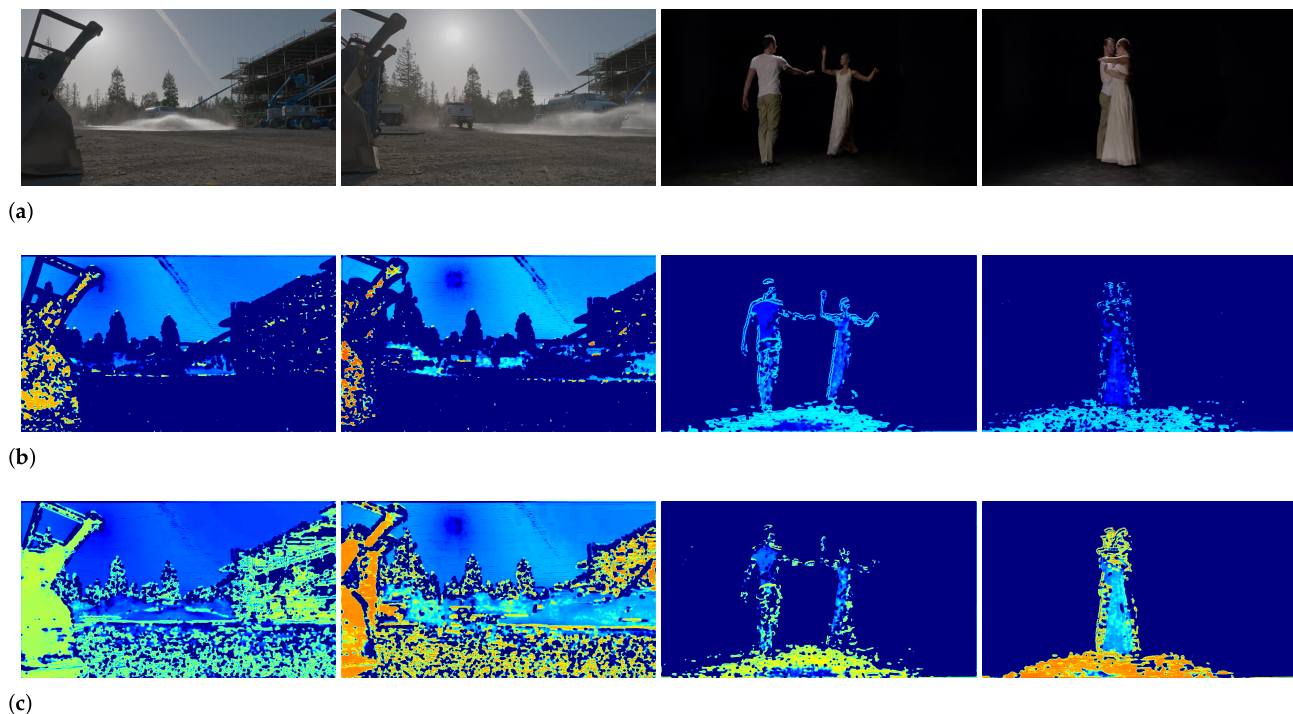
Figure 10. Visual comparison of spatial feature extraction. ( a ) shows the distorted UHD frames. ( b ) presents the feature maps produced by the Resnet-50 model. ( c ) presents the feature maps produced by the proposed SR-SDFNet